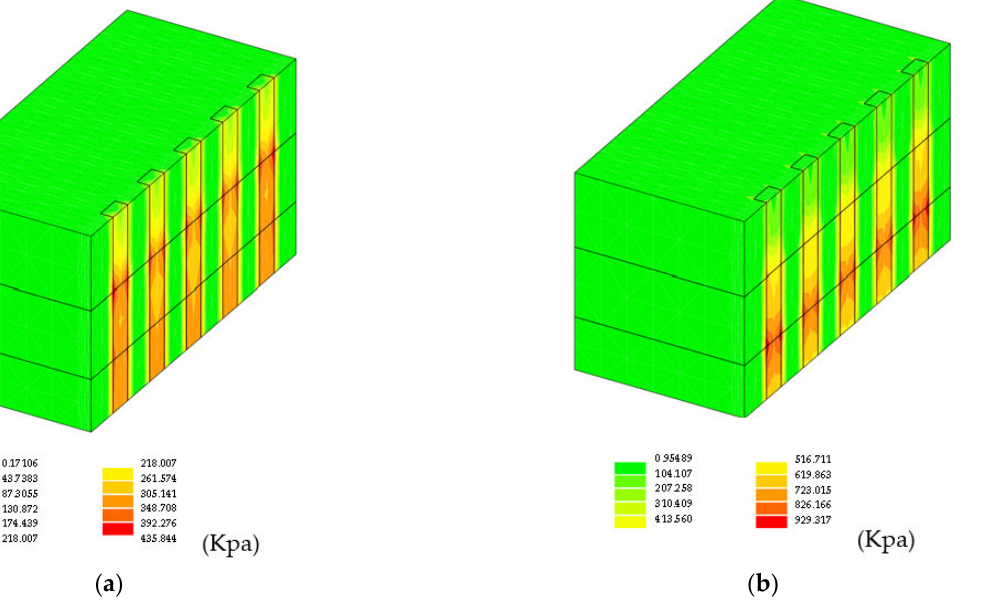
Figure 13. Iso ‐ value of the second deviatoric stress of the retaining piles obtained with the 3D FEM analysis for ( a ) the first ‐ stage stratum excavation and ( b ) the second ‐ stage stratum excavation.